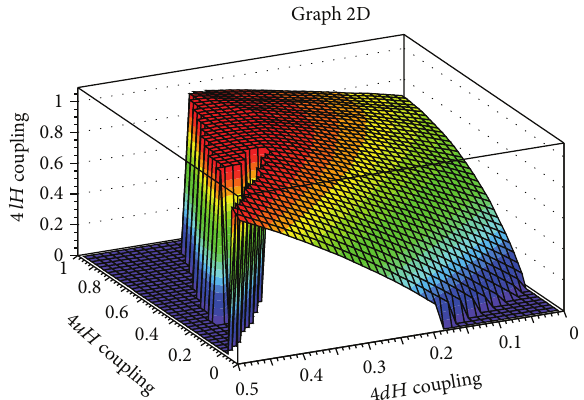
Figure 8: The surface in the space of parameters of the suppression factors 4𝑑𝐻 , 4𝑢𝐻 , and 4𝑙𝐻 in the Higgs coupling to the quarks and leptons of the 4th generation, at which the median value of ratio 𝑅 = 1.3 , measured in the ATLAS experiment at LHC [37], is reproduced.